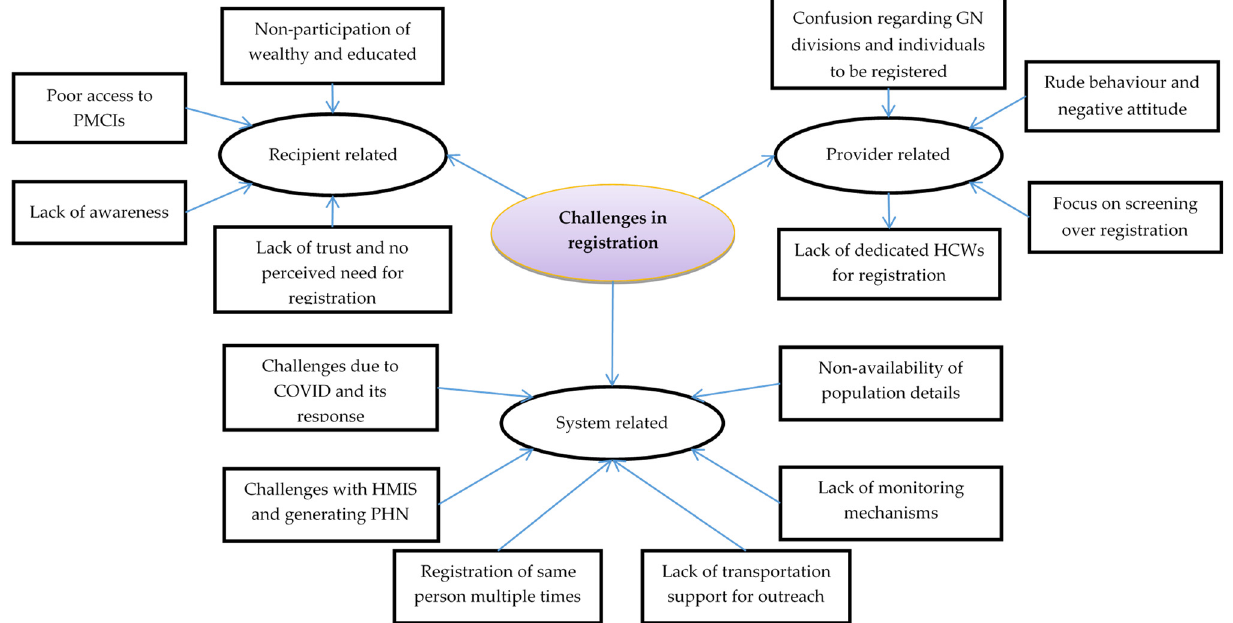
Figure 4. Challenges in registration of the identified population in the PMCIs supported by PSSP in Sri Lanka, 2021. Abbreviation: HCWs: Health Care Workers; PMCI: Primary Medical Care Institution; PSSP: Primary Health Care System Strengthening Project (PSSP); HMIS: Health Management Information System; PHN: Personal Health Number.